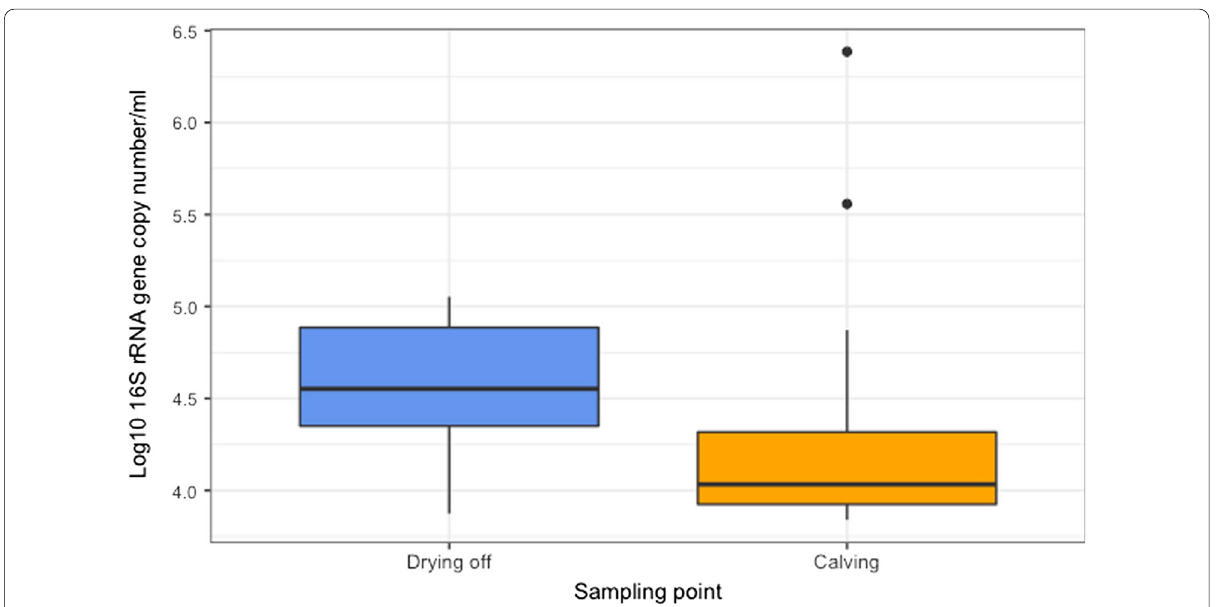
Fig. 2 Mean log (10) 16S rRNA gene counts per ml milk at drying off and